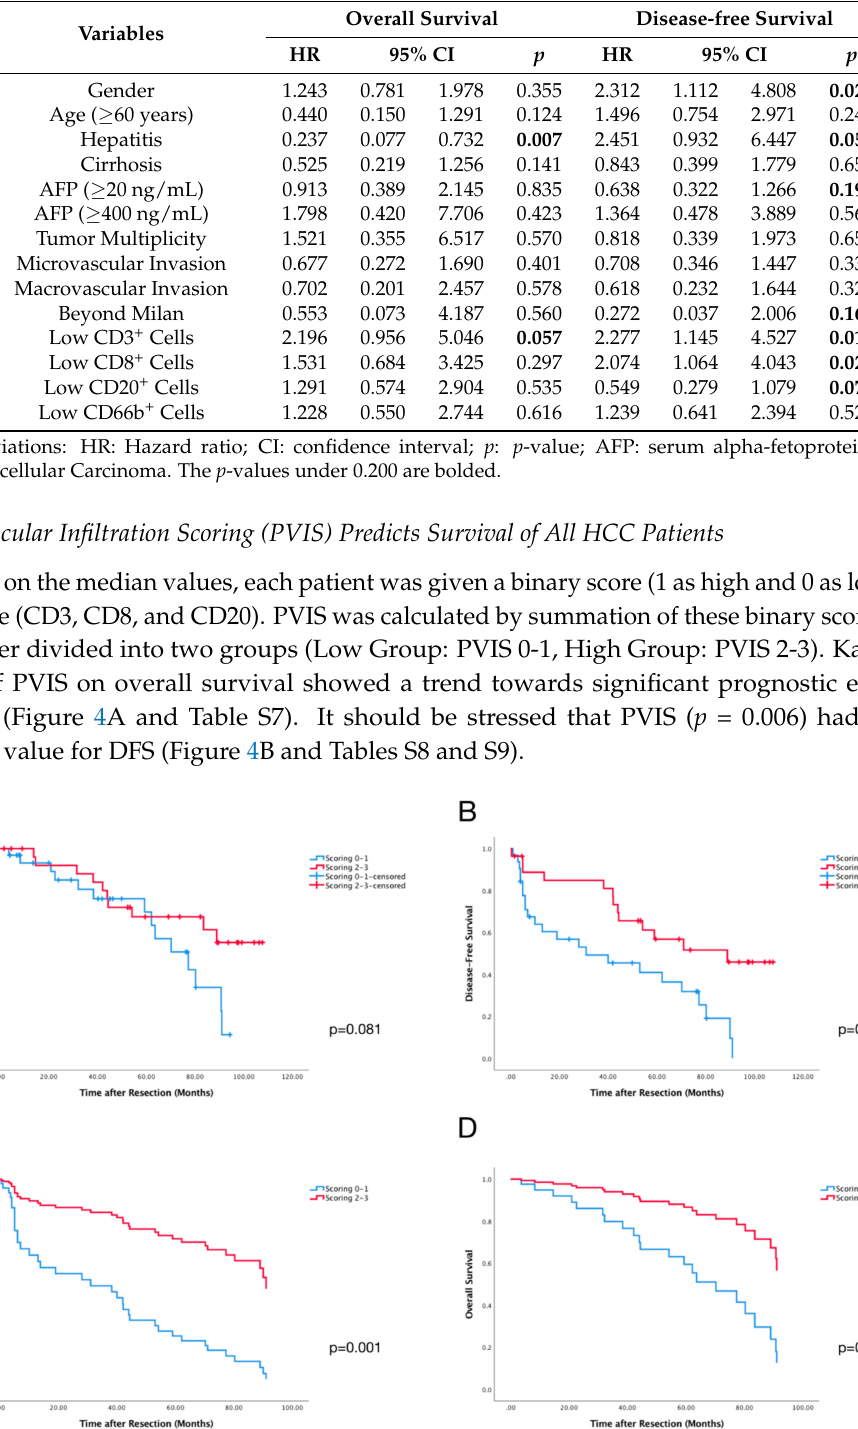
Table 2. Univariate Analysis of All Factors on OS and DFS in all Hepatocellular Carcinoma (HCC) Patients ( n = 60).